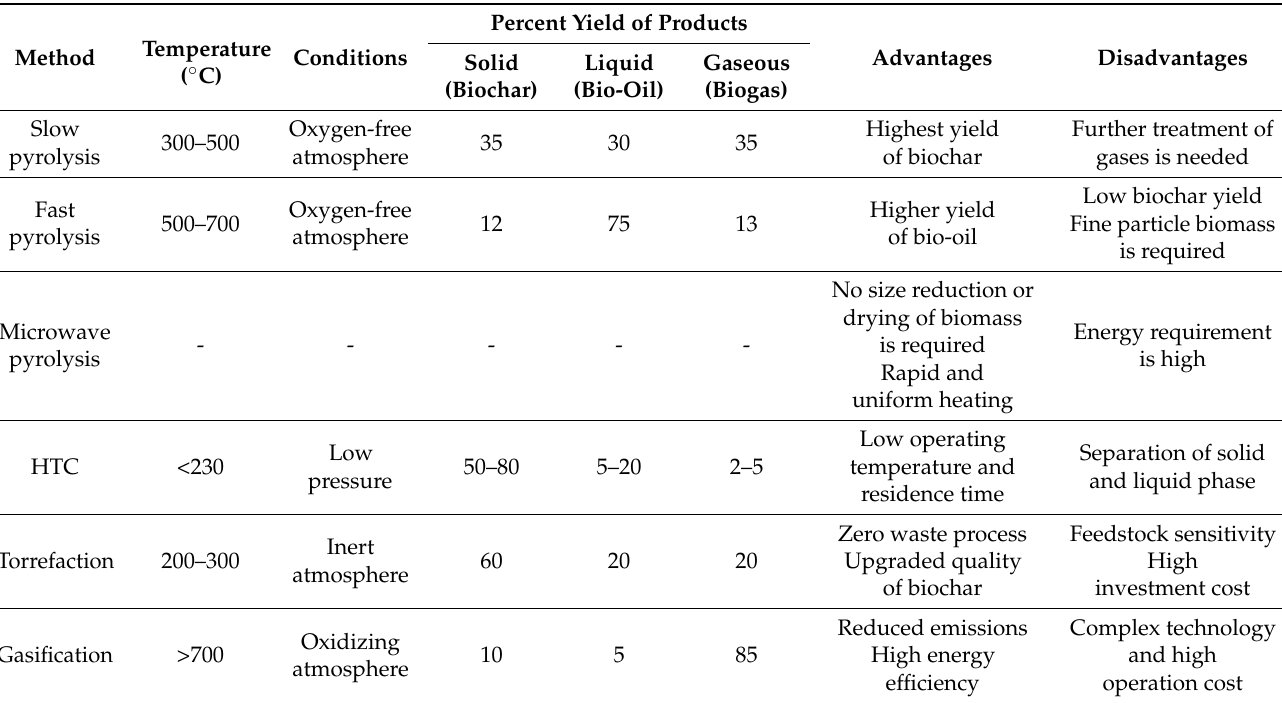
Table 1. Percentage yield of solid, liquid, and gaseous products obtained from biochar by various routes